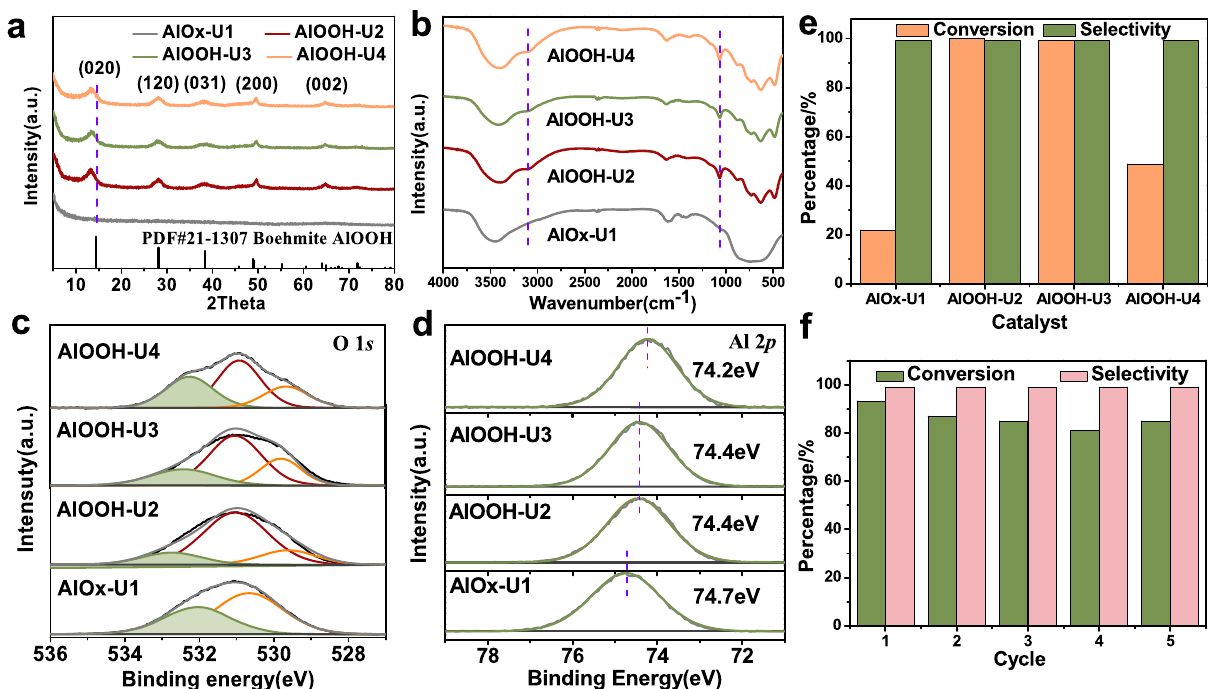
Fig. 3 Characterization and activity of the AlOOH catalyst. a XRD b FTIR c O1s and d Al 2p XPS and e Reactivity comparison of different catalyst. f Catalyst recycling of AlOOH-U2. Catalyst (50 mg), temperature (80 °C), H 2 pressure (2 MPa), time (6 h), styrene (0.5 mmol), THF (2 mL), stirring speed (600 rpm) and n-decane as internal standard. Table 1 The catalytic activity of AlOOH-U2 with different treatment